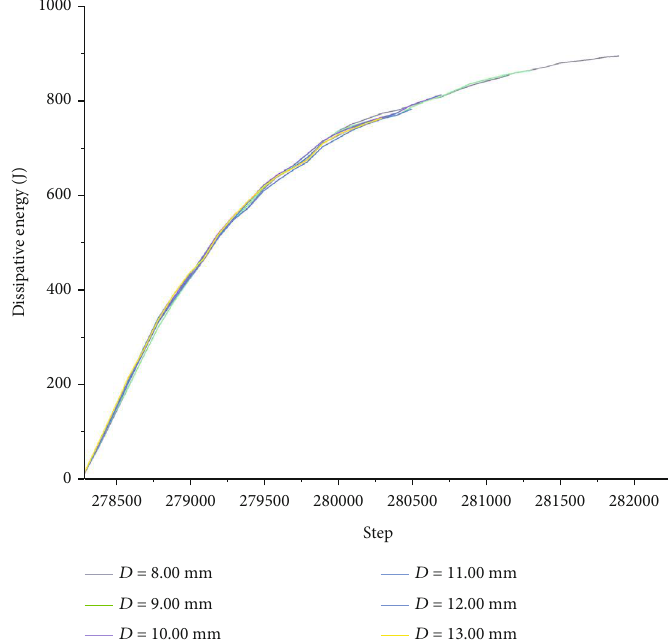
Figure 16: Variation diagram of dissipated energy under di ff erent core diameter